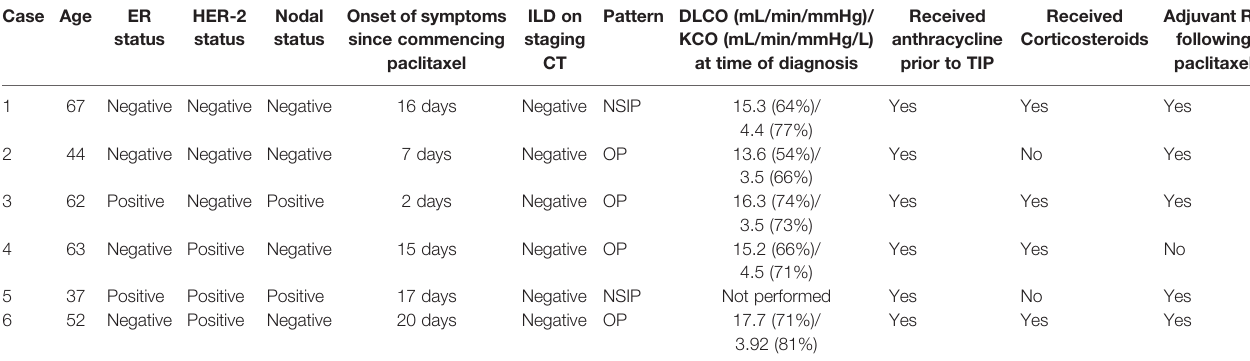
TABLE 1 | Summary of patient ’ s demographics, diagnosis and